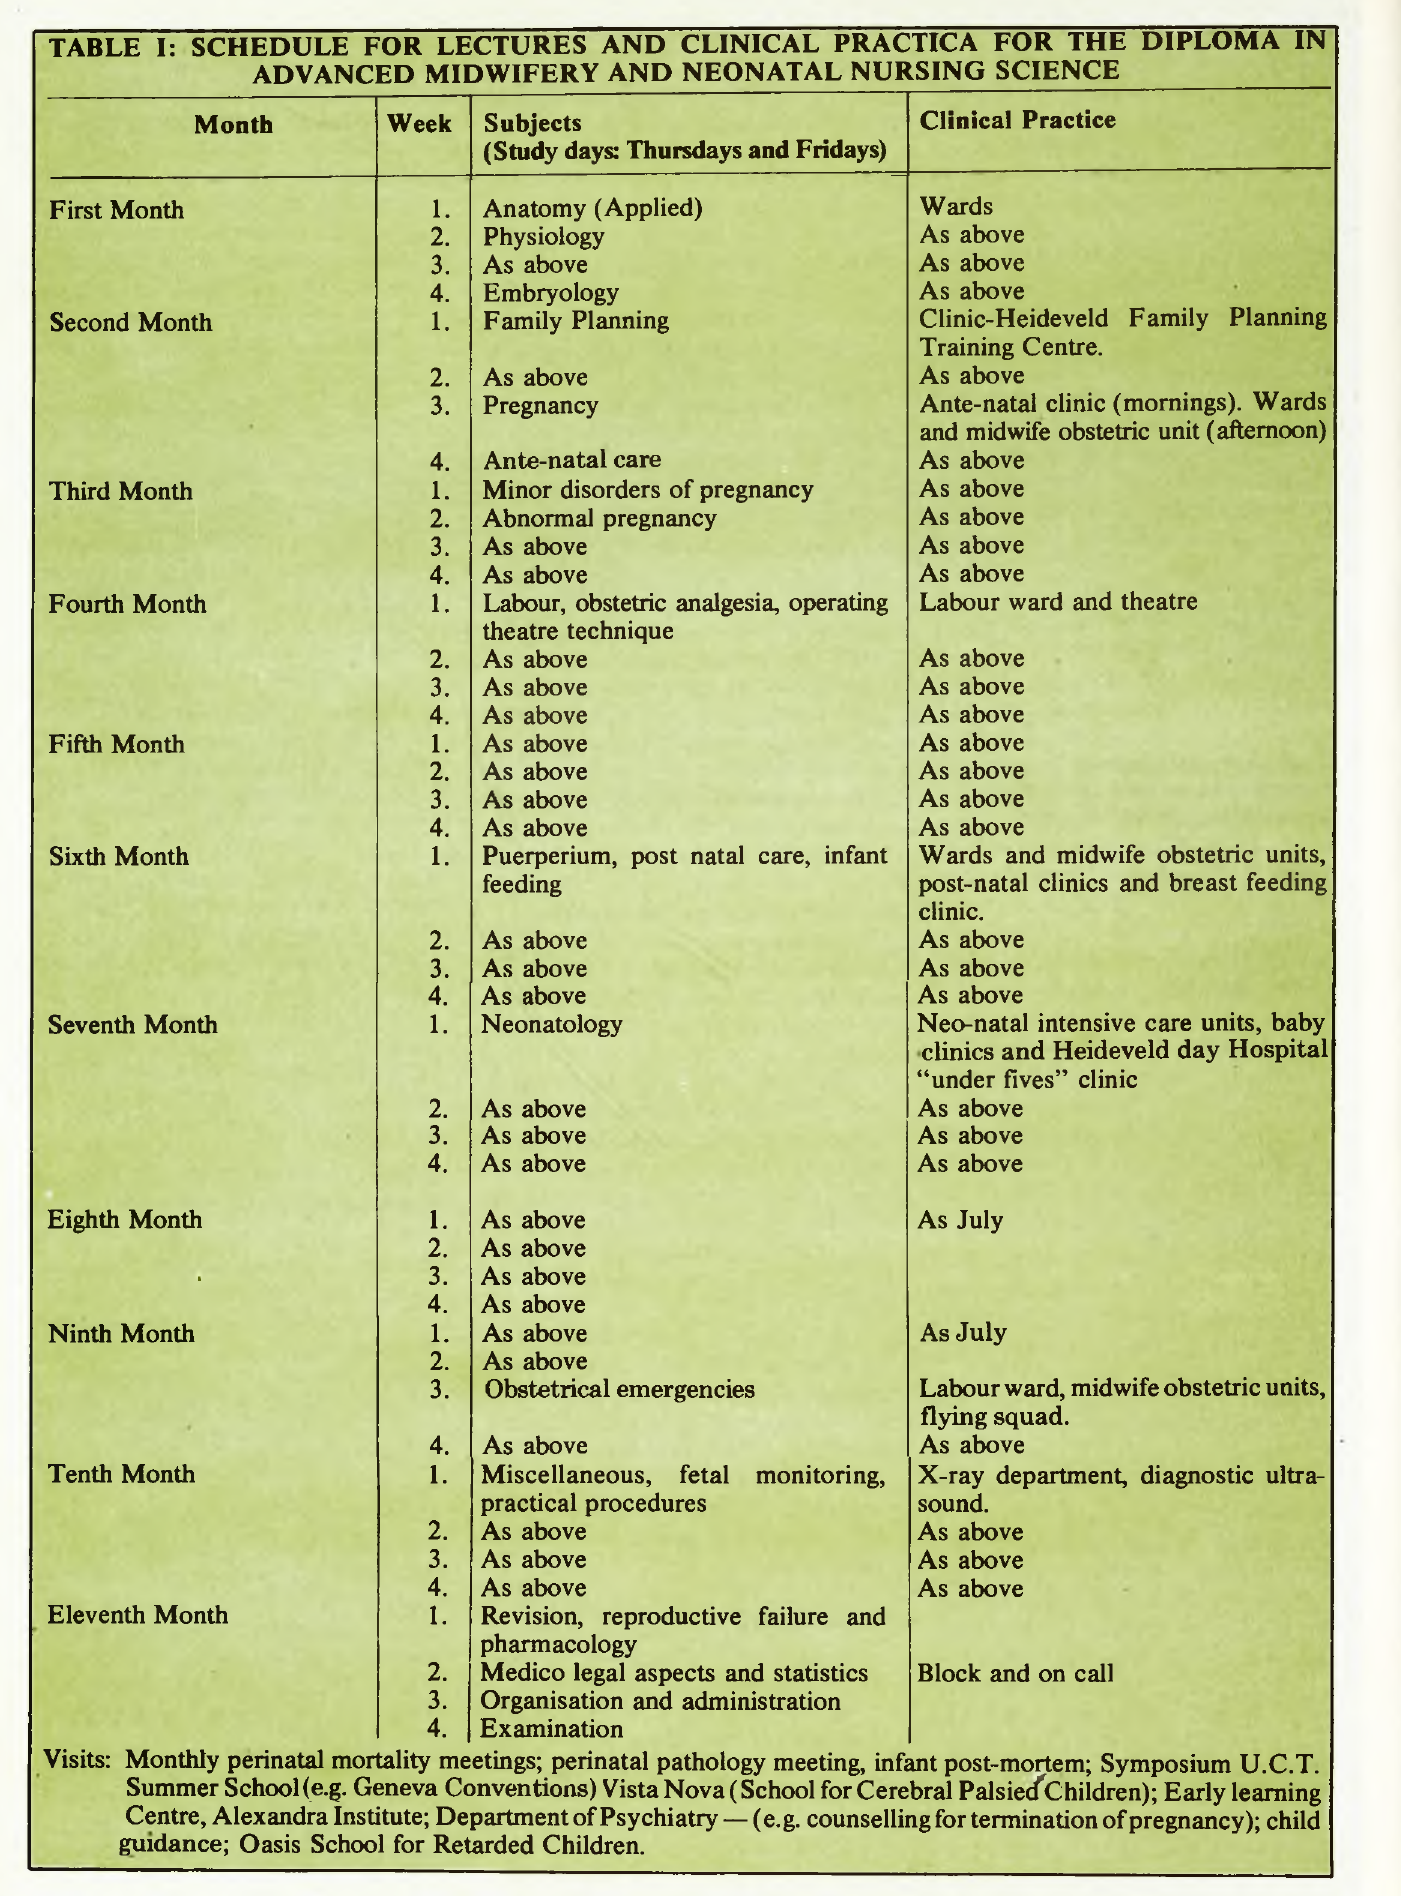
TABLE I: SCHEDULE FOR LECTURES AND CLINICAL PRACTICA FOR THE DIPLOMA IN ADVANCED MIDWIFERY AND NEONATAL NURSING SCIENCE Clinical Practice Month Week Subjects (Study days: Thursdays and Fridays) First